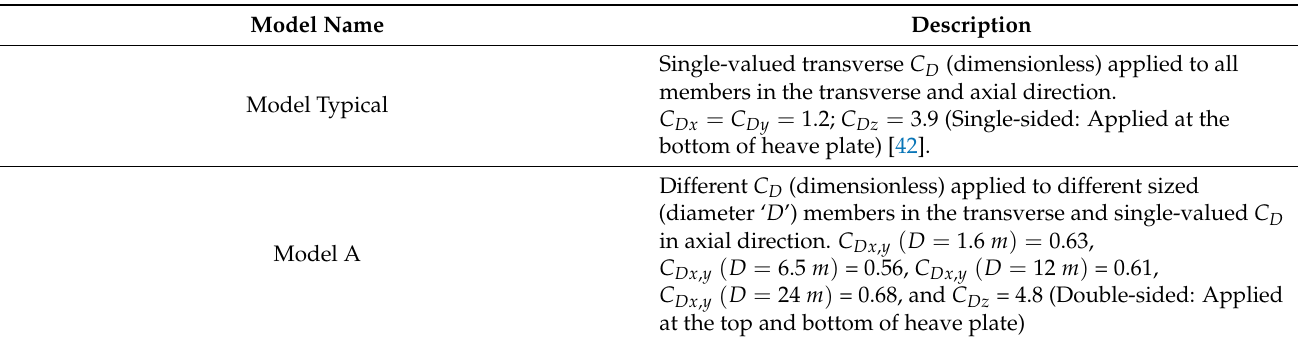
Table 3. Drag force application in OpenFAST using the Morison drag